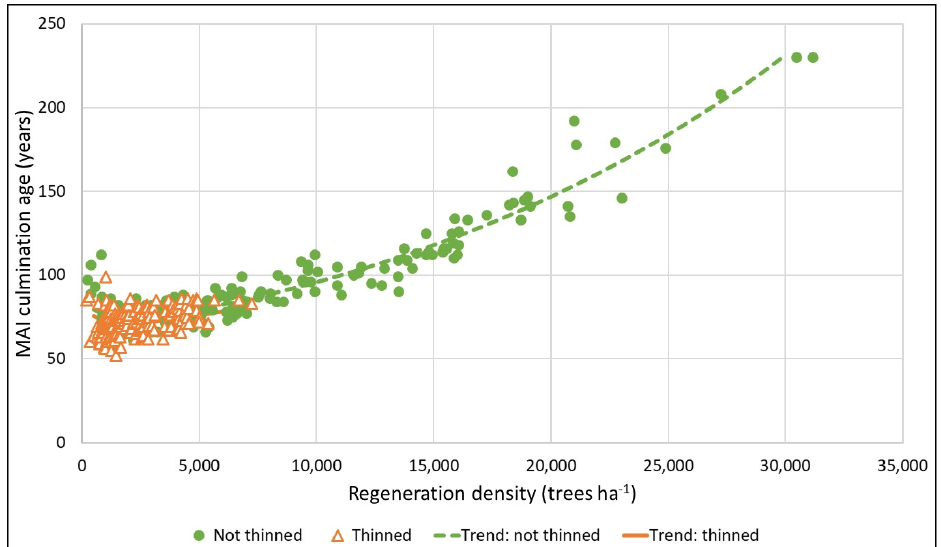
Forests 2022 , 13 , x FOR PEER REVIEW